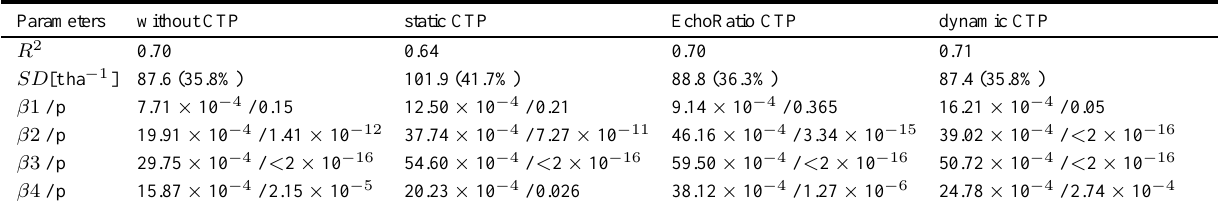
Table 3. Accuracy statistics of the fitted AGB models. R 2 , SD of the prediction errors and the estimated β coefficients with their corresponding p-values (from t-test) are shown.